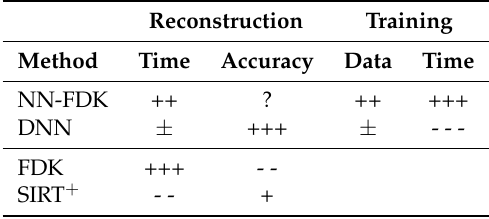
Table 1. Comparison of reconstruction methods with respect to the goals formulated in Section